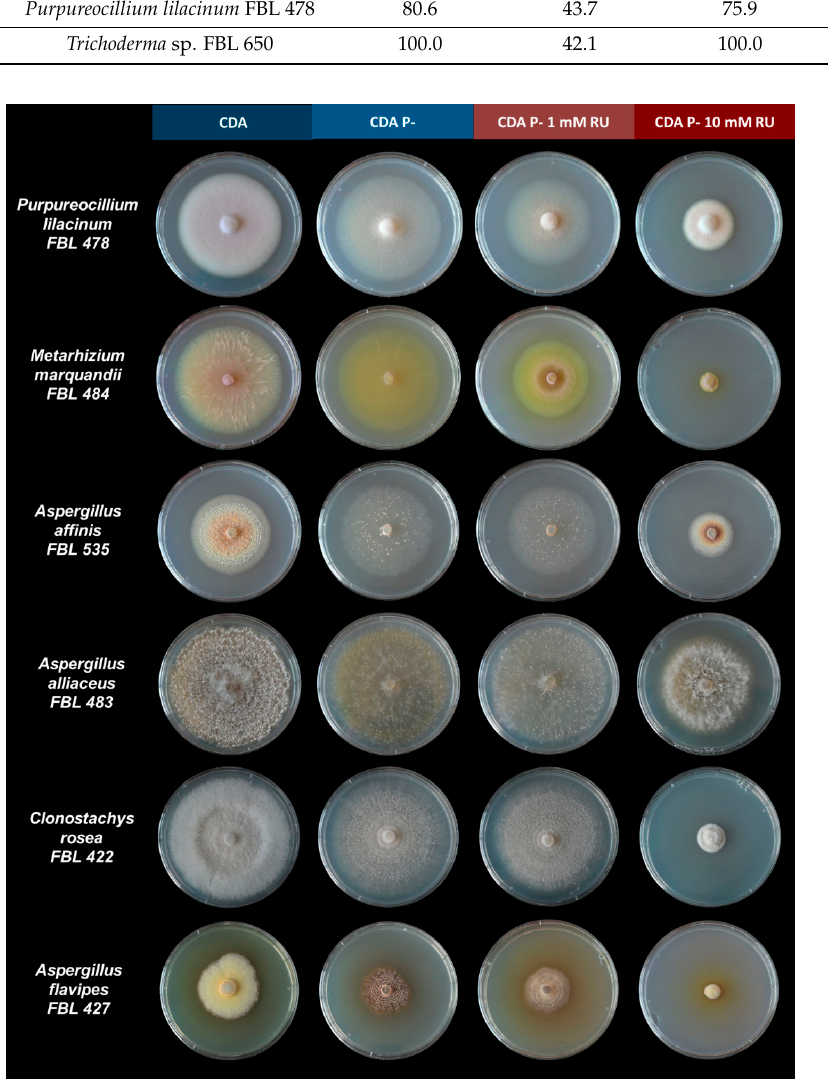
Figure 1. Morphological characteristics of the selected strain colonies in the controls on Czapek Dox Agar (CDA), negative controls on Czapek Dox Agar without phosphorus (CDA P − ), 1 mM RU treatment on Czapek Dox Agar without phosphorus (CDA P − 1 mM RU), and 1 mM RU treatment on Czapek Dox Agar without phosphorus (CDA P − 10 mM RU) at 14 days of Table 5. Tolerance index (R t :R c ) of the tested species exposed to Roundup as the only source of P or C on enriched CDA.